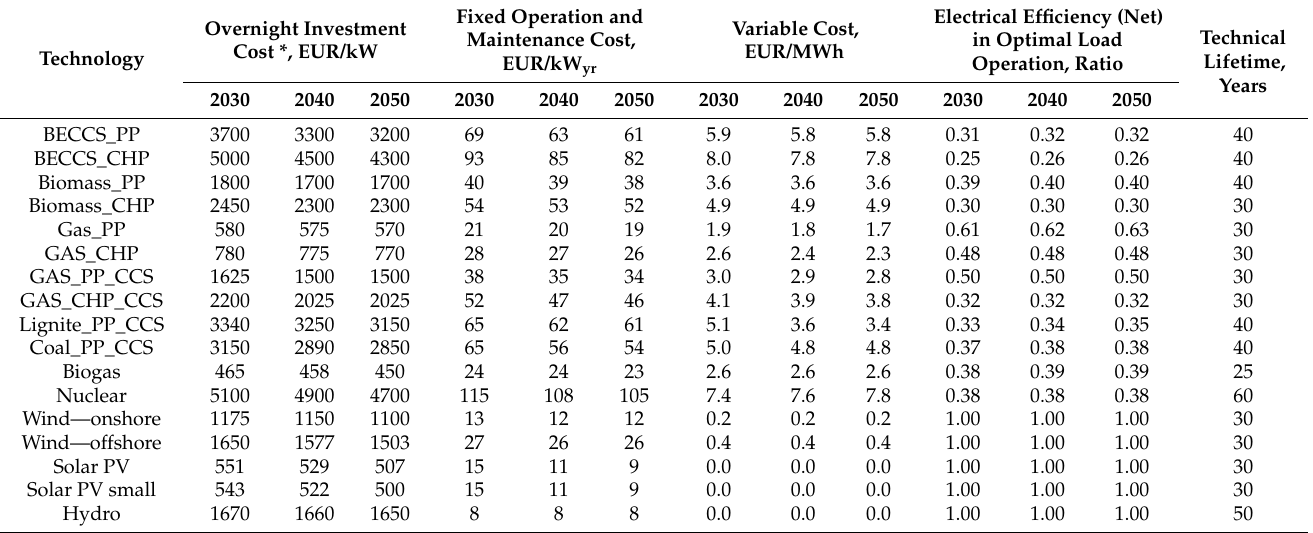
Table 1. Techno-economic parameters of key technologies covered by the model for selected years. Source: Primes [54] and own